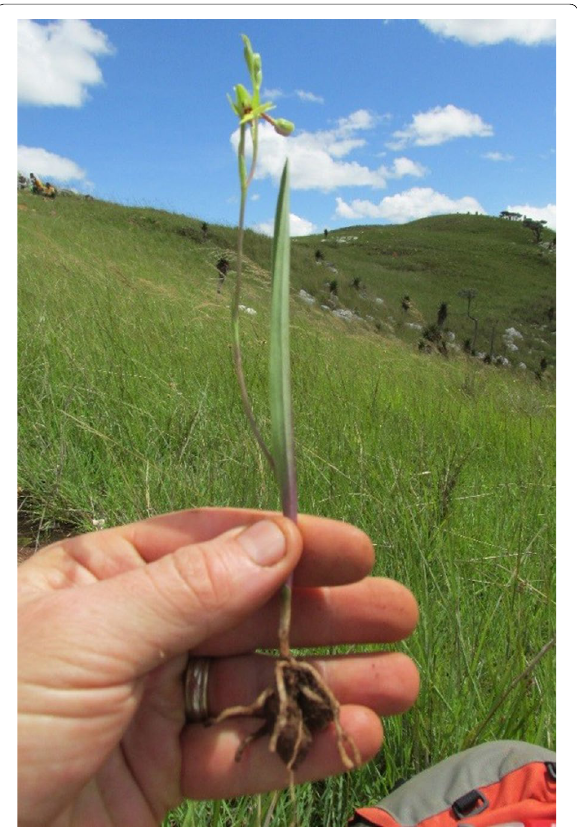
Fig. 2 (Right)—The terrestrial orchid, Cynorkis flexuosa , shown against the backdrop of open rocky grassland of the Itremo Massif. There are ca 135 species of Cynorkis species in Madagascar alone. The lateral branch roots on this specimen were detached and transported to labs in the United States (Illinois) and United Kingdom (Kew) for fungal